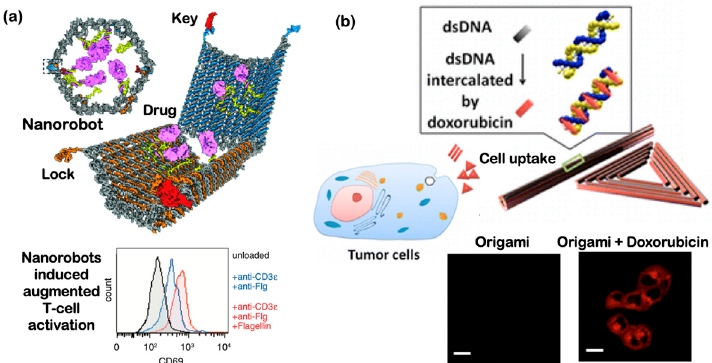
Figure 9. DNA-base nanomedicine: ( a ) Targeted drugs are sequestered within the interior of 3D DNA nanorobot with a controllable key-lock pair for specialized delivery purpose. Nanorobots loaded with combinations of antibody fragments are used in different types of cell-signaling stimulation (T-cell activation) in tissue culture; adapted with permission from [167]. Copyright 2012, Science. ( b ) Doxorubicin-loaded DNA nanostructures as an emerging delivery vehicle. Origamis with doxorubicin are successfully taken up by the cells as visualized via confocal fluorescent analyses. Adapted with permission from [166]. Copyright 2015, American Chemical Society.